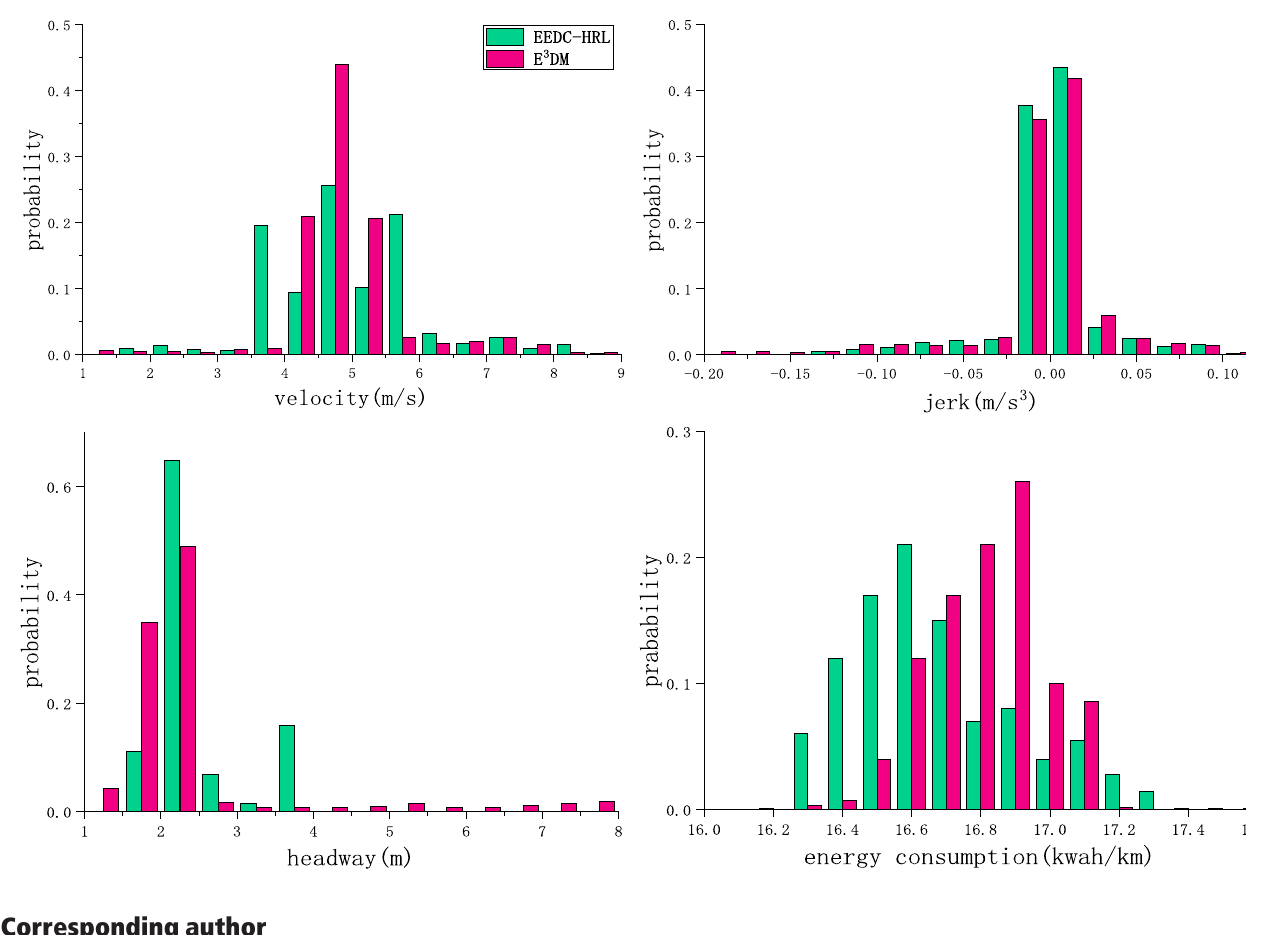
Figure A3 The data distribution of each performance indicator in the congested traf fi c fl